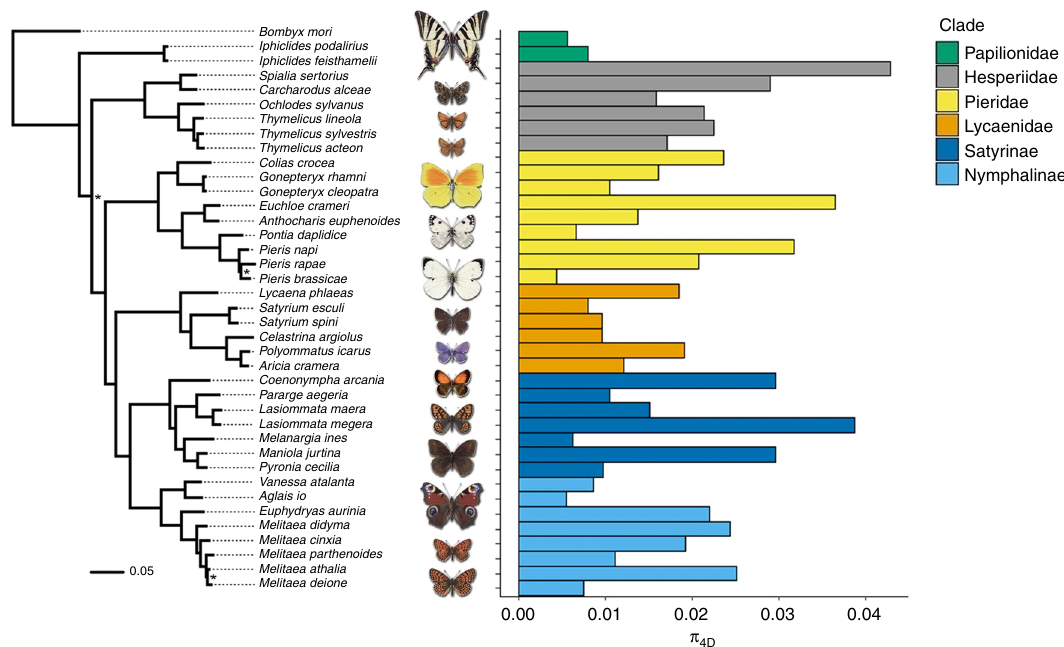
Fig. 1 Neutral genetic diversity ( π 4 D ) across European butter fl y species. The phylogeny is based on 218 single-copy orthologues and rooted with the silkmoth Bombyx mori as an outgroup. All nodes have 100% bootstrap support unless marked with an asterisk (70 – 99%). The barplot on the right shows genome-wide estimates of π 4 D for 38 focal species sampled from the six major groups of Papilionoidea present in Europe. The phylogeny explains very little of the variation in π 4 D in butter fl ies. Source data are provided as a Source Data fi